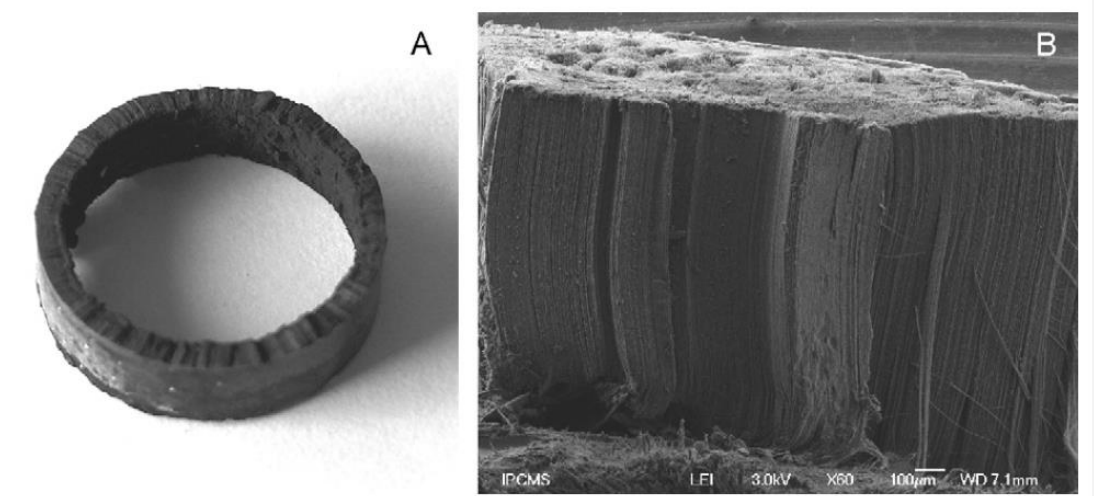
Figure 4. Macrostructures of self-supported aligned carbon nanotubes obtained after dissolving the quartz growth substrate in a HF solution: (A) ring and (B) plate (Janowska et al., 2008) The CNT array was relatively dense with a spacing of about 100 nm between neighboring